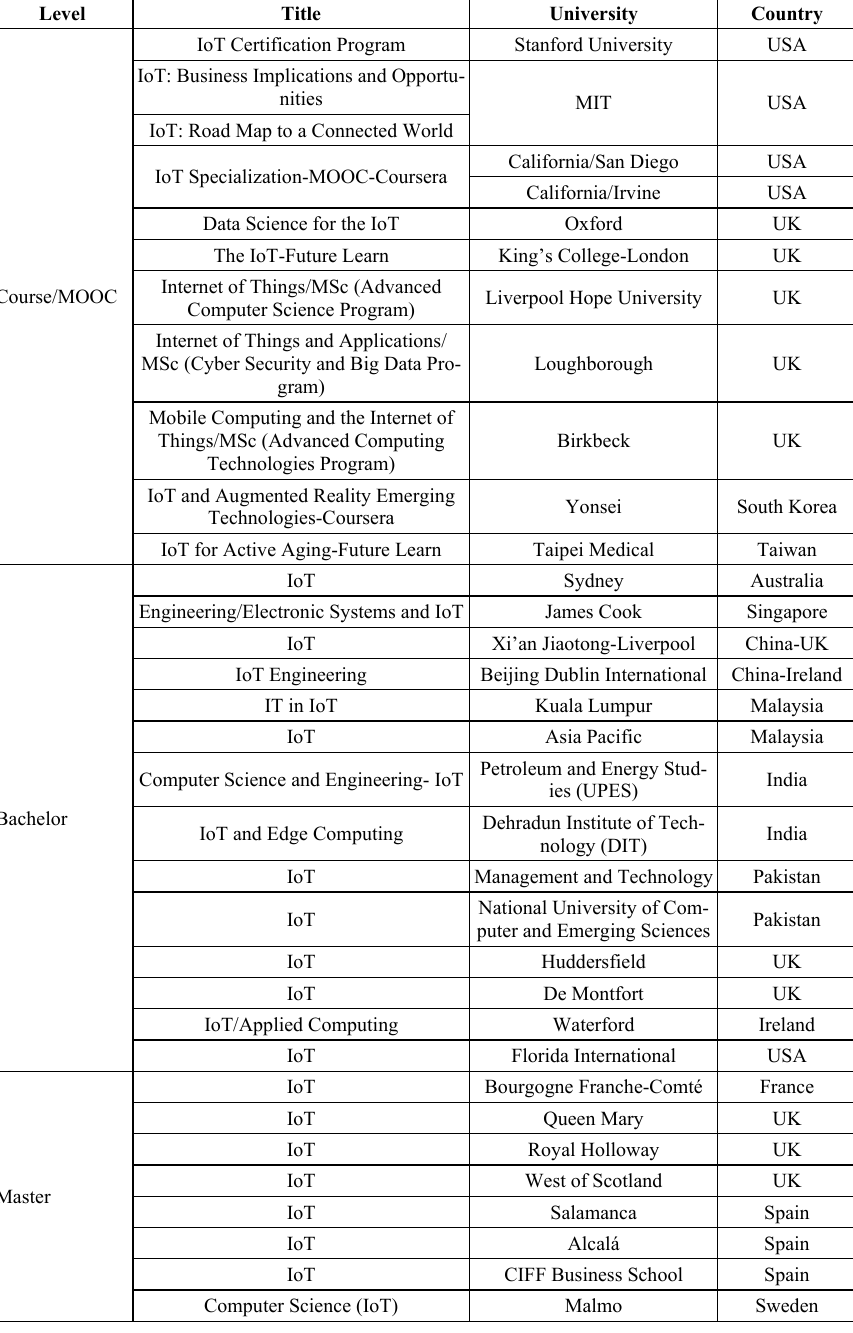
Table 1. MSc and BSC Programs and Individual Courses in IoT in Universities Worldwide